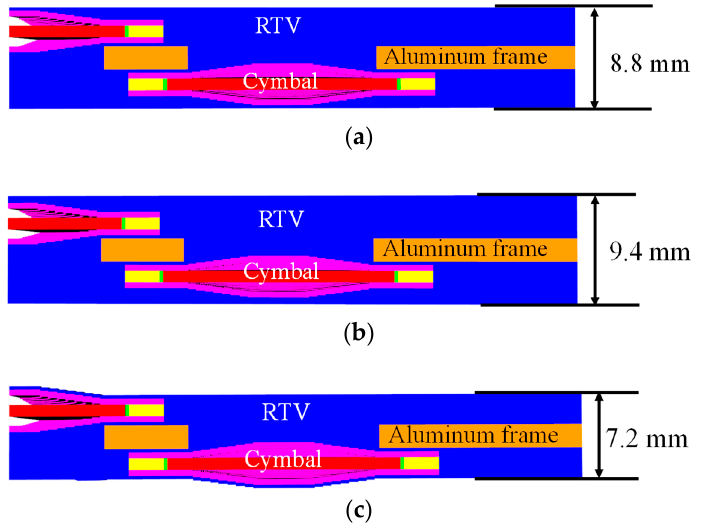
Figure 7. Schematic of the cymbal array potted by: ( a ) method 1; ( b ) method 2; ( c ) method 3.